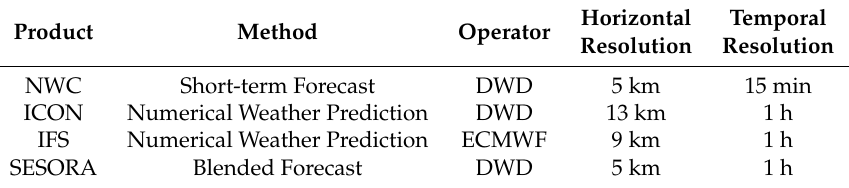
Table 1. Information on the forecasted solar radiation data used in this